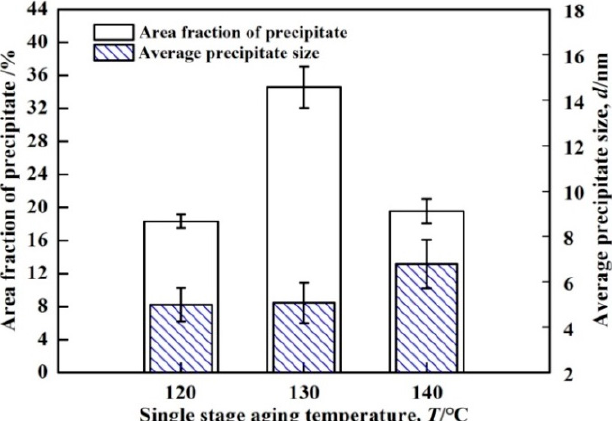
Figure 10. Area fraction of precipitates and average precipitate sizes aged at different temperatures for 24 h.